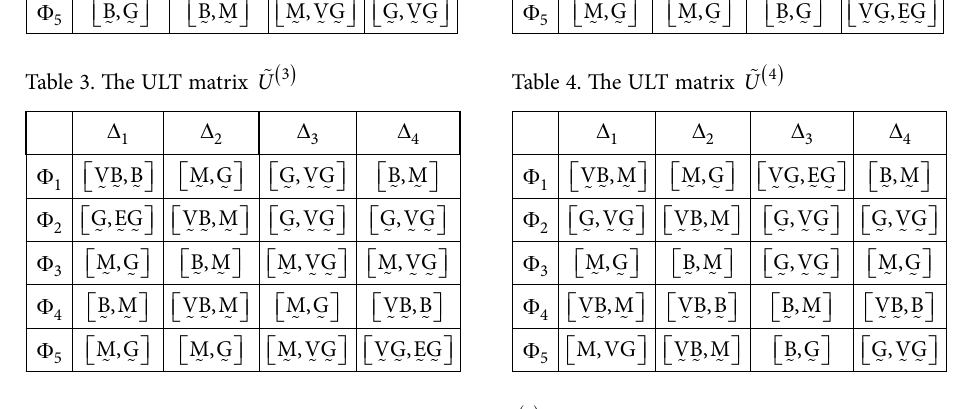
Table 5. The ULT